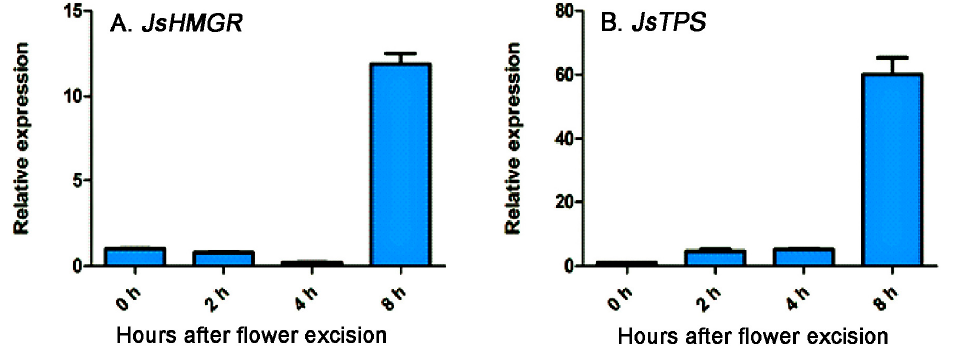
Figure 5. Relative expression of JsHMGR ( A ) and JsTPS ( B ) genes in J. sambac ‘Bifoliatum’